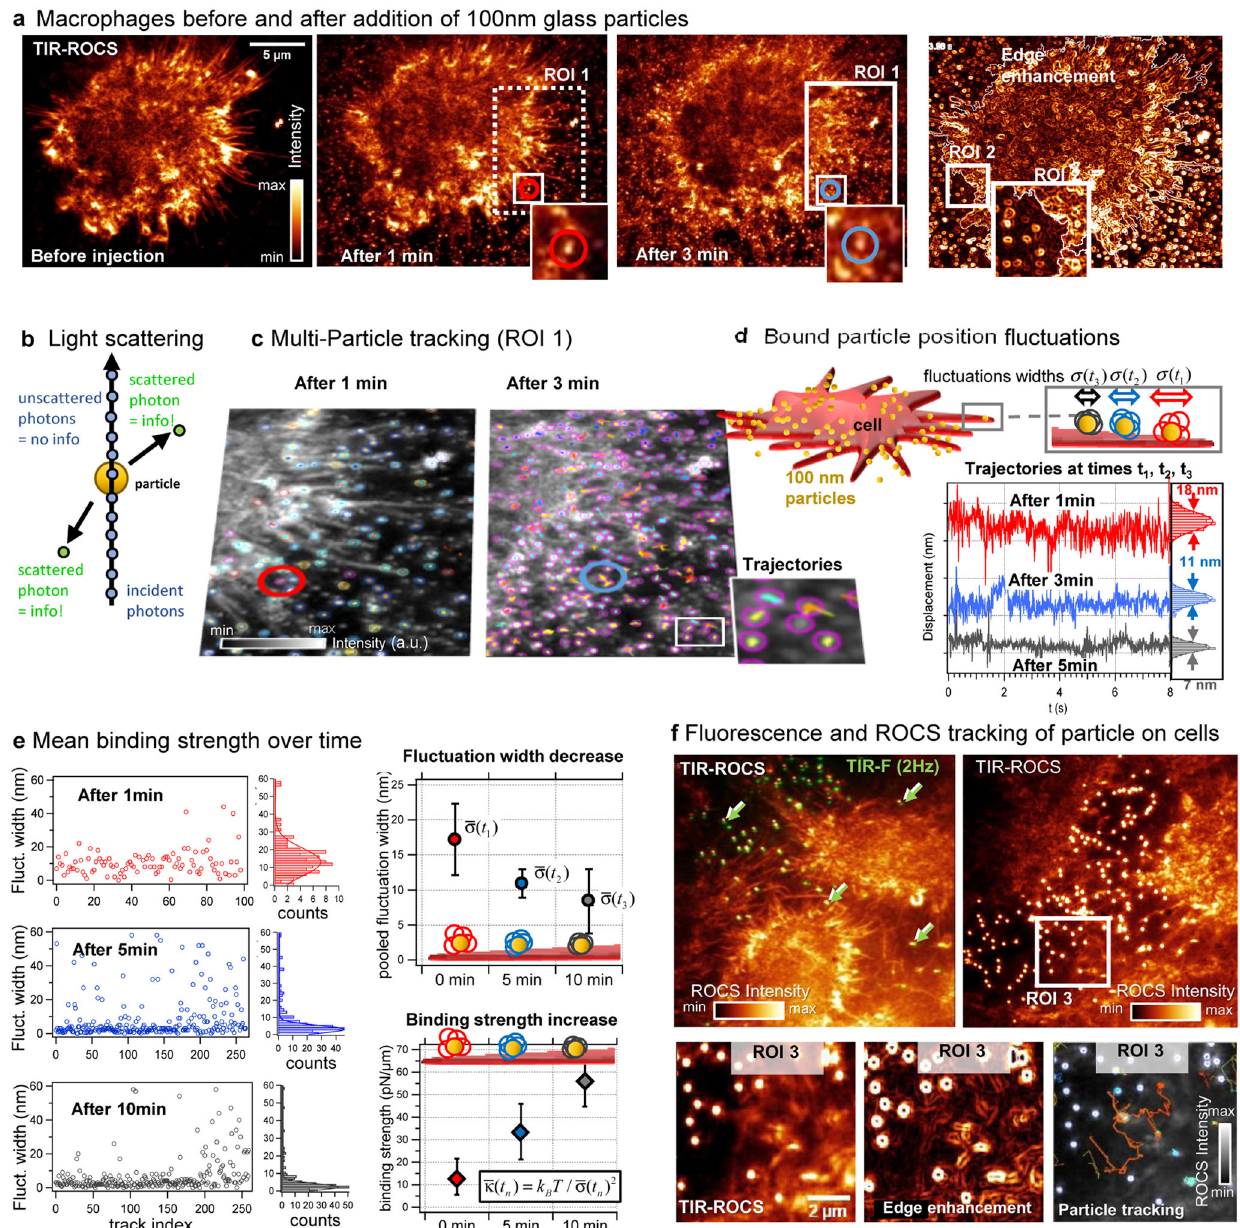
Fig. 6 ROCS microscopy of particle binding on a thermal noise level. a TIR-ROCS images (10 ms integration time) of J774 macrophages before exposure of 100 nm glass particles, 1 min after injection and 3 min after injection. ImageJ edge fi nder increases visibility and high particle densities. b A 100 nm glass particle scatters less than 0.6% of incident photons. 0.03 · 0.6% of scattered photons reach the detector carrying information about particle motions. c More than 100 particles are tracked automatically within region ROI 1 after 1 and 3 min. A particular particle is marked by a red and blue circle. d Position fl uctuations of particles bound to the cell surface are analyzed by the position fl uctuation standard deviations σ (t). e Temporal evolution of mean fl uctuation widths (cid:1) σ and binding strengths (cid:1) κ of ca. 260 particles after t = 1 min, 5 min and 10 min. Within 10 min, the mean binding strength (cid:1) κ has increased about fi vefold. Errors bars indicate STD. f Left: image of unlabeled cells with fl uorescent-labeled particles recorded with both TIR-ROCS (at 100 Hz) and TIR-F (at 2 Hz). Particles (see 4 white/green arrows) bound to cells are visible with TIR-F (in green, shifted) and with TIR-ROCS (in white/orange). Right: ROCS image of cells with particles. ROI 3 with bright particles in front of cellular structures allowing precise 100 Hz particle tracking. Source data are provided as a Source Data fi